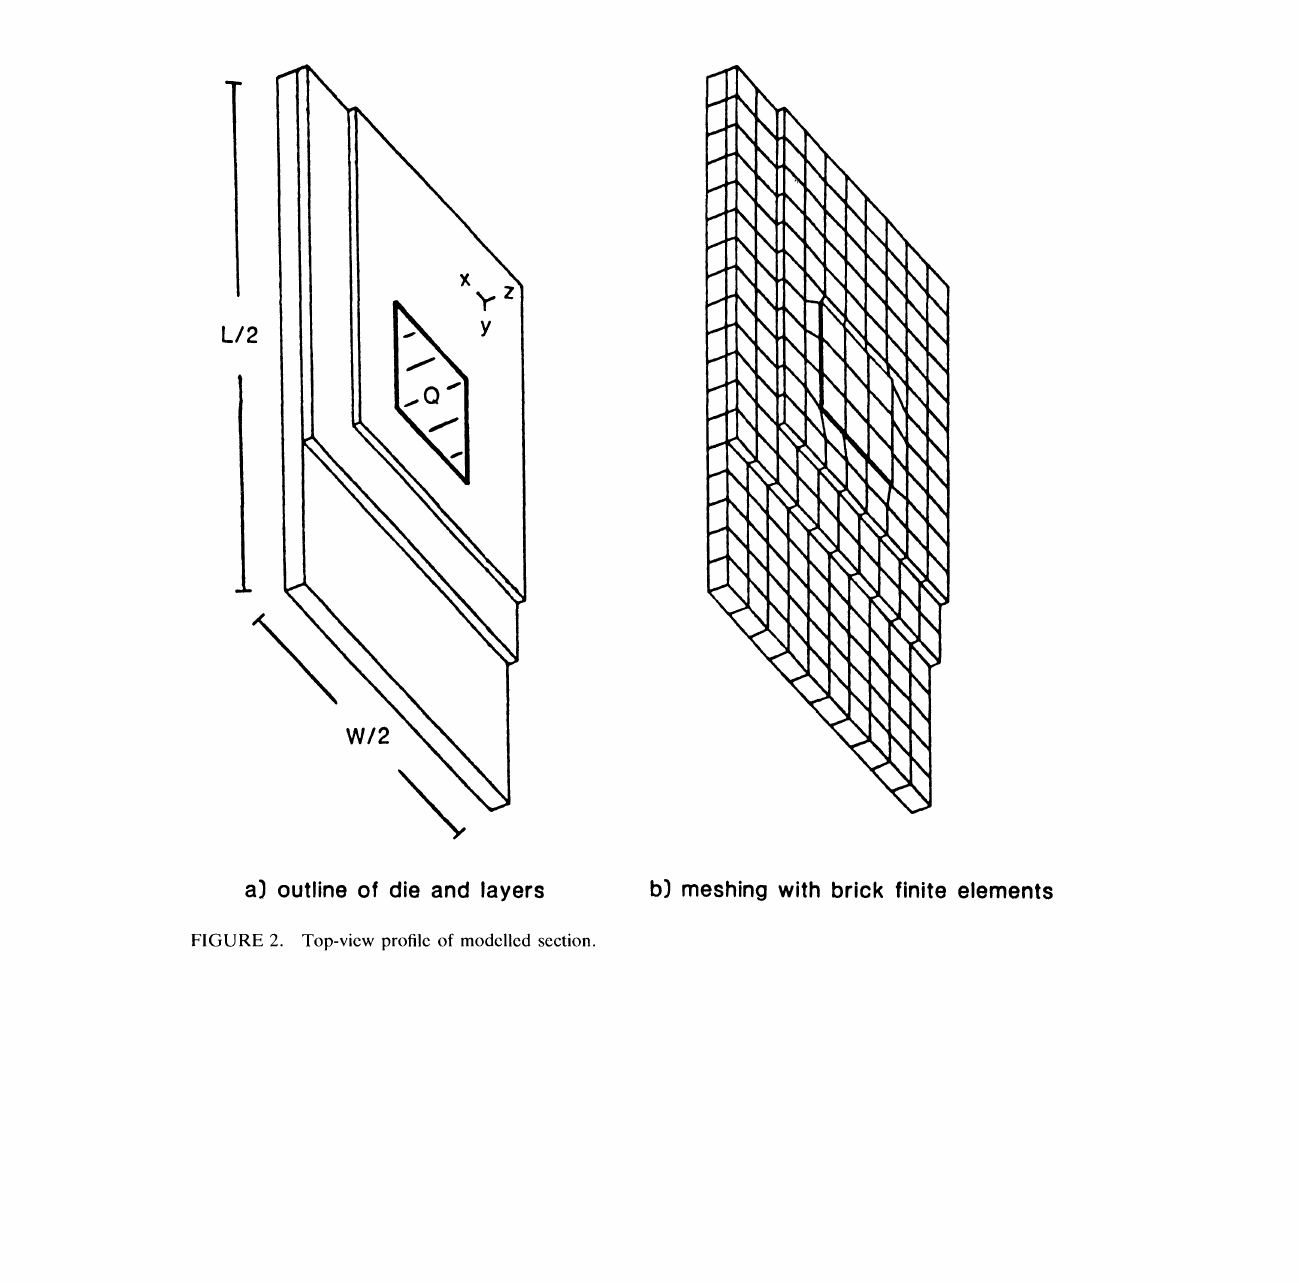
FIGURE 2. Top-view profile of modelled